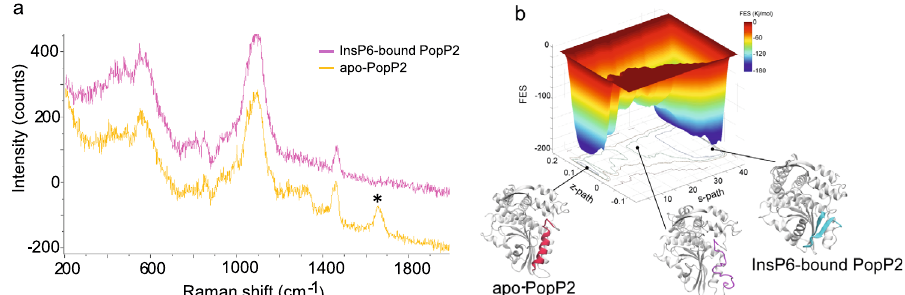
Fig. 3 InsP6 induces fold switch of PopP2. a Raman spectra of PopP2 in the absence (yellow) or presence (pink) of InsP6. b Metadynamics simulation result of the fold-switching process of PopP2. Free energy pro fi le acquired from metadynamics simulation is shown on the top, “ s-path ” means progress along the path, “ z-path ” means deviation along the